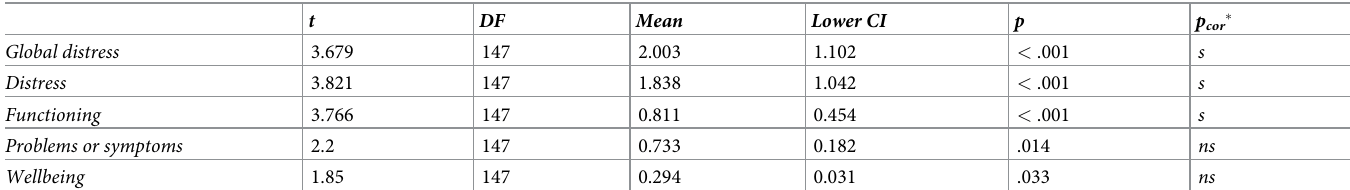
Table 1. Results of one-sample t-tests on CORE-OM change scores for Study